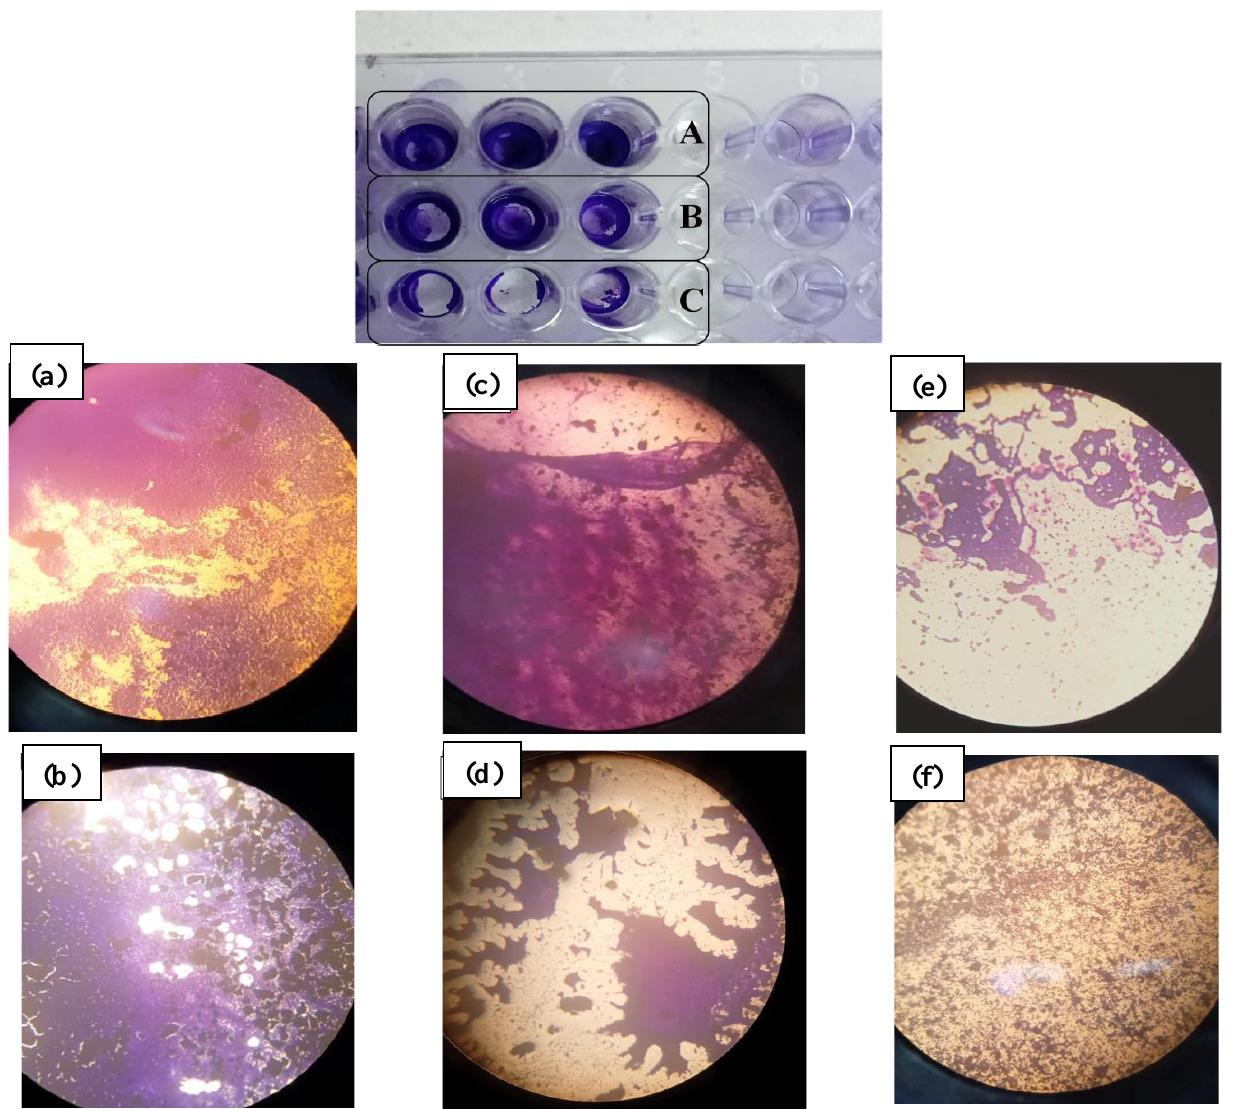
Figure 10. Bacterial biofilm formation on the surface of polystyrene. ( A ) E. faecalis strain appears to